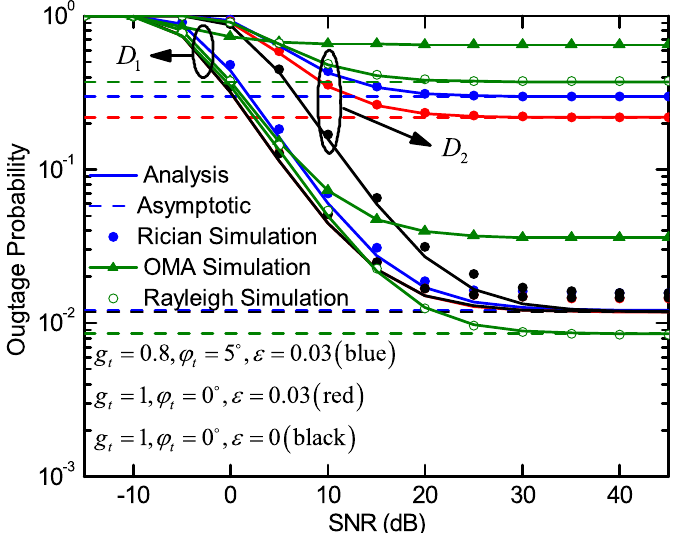
Figure 2. Outage probability versus the transmit SNR of the proposed TWR C-NOMA system for D 1